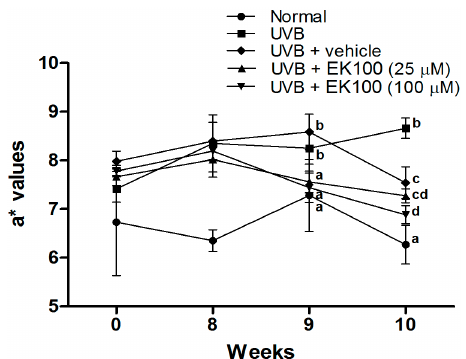
Figure 2. Effect of EK100 on a* values in chronic UVB-irradiated hairless mice. UVB irradiation significantly increased the a* values of the mouse skin in the 8th, 9th, and 10th weeks; however, EK100 treatment reduced the a* values in the 9th, and 10th week. a–d : Values not followed by a common letter are significantly different ( p < 0.05).